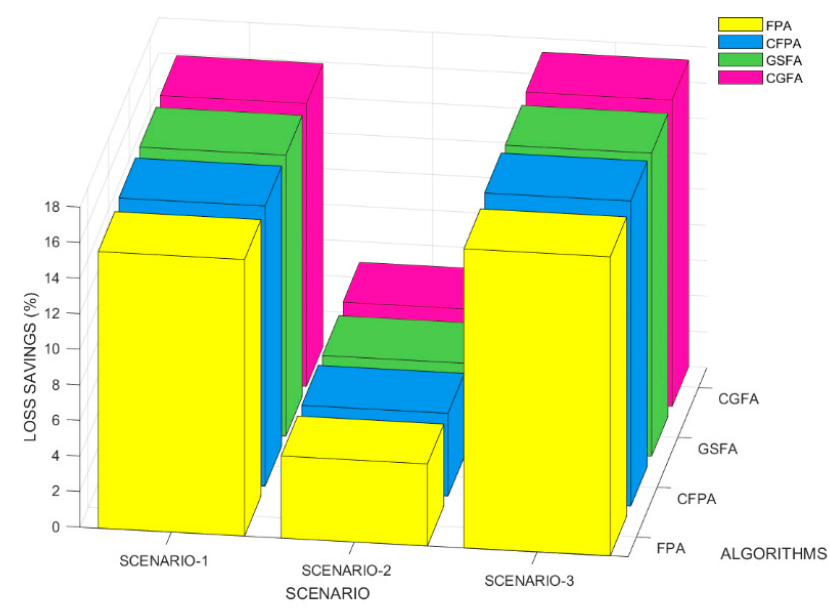
Figure 10. Percentage loss savings of different algorithms in an IEEE 119-bus system.